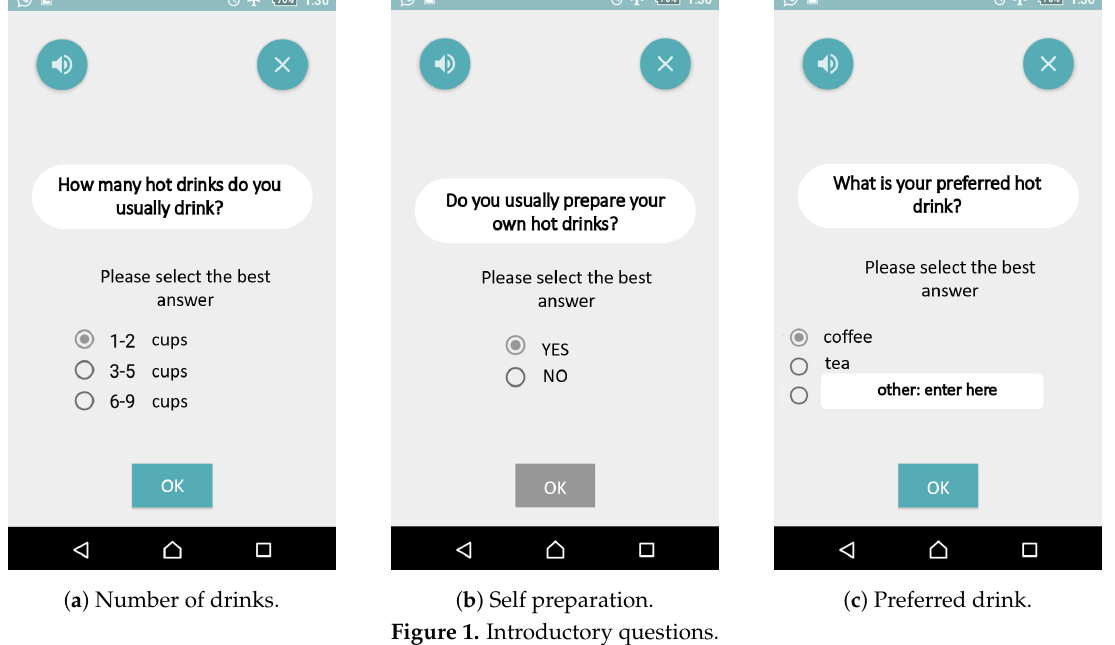
Figure 1. Introductory